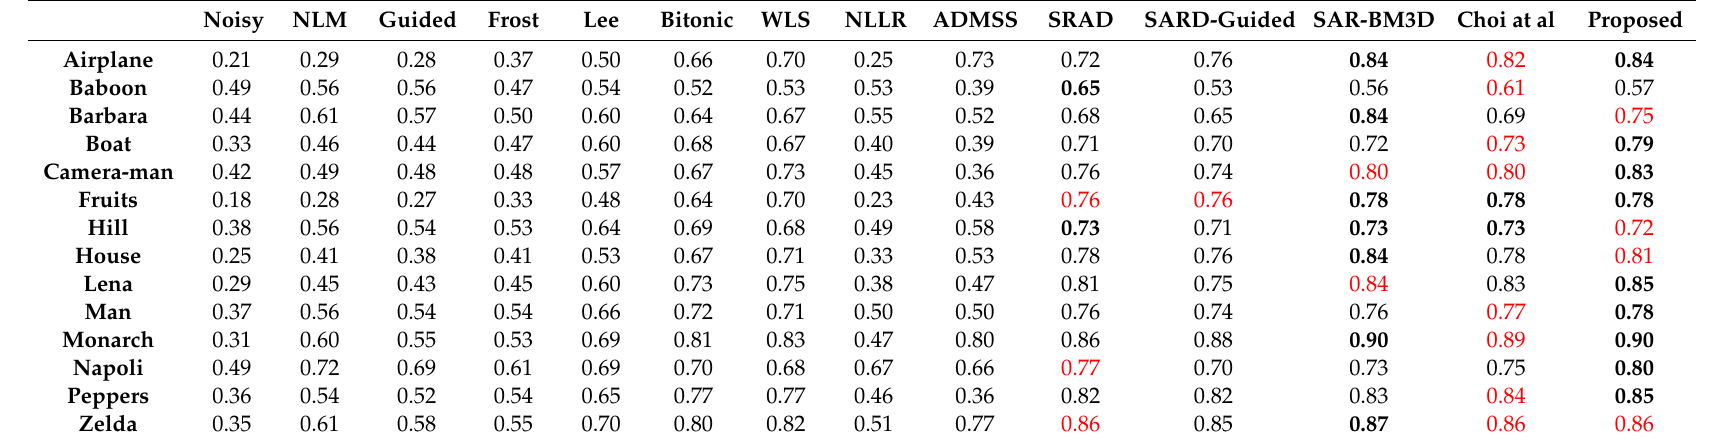
Table 5. Structural similarity (SSIM) results for each standard image (The best value is shown in bold and the second-best value is shown in red color).